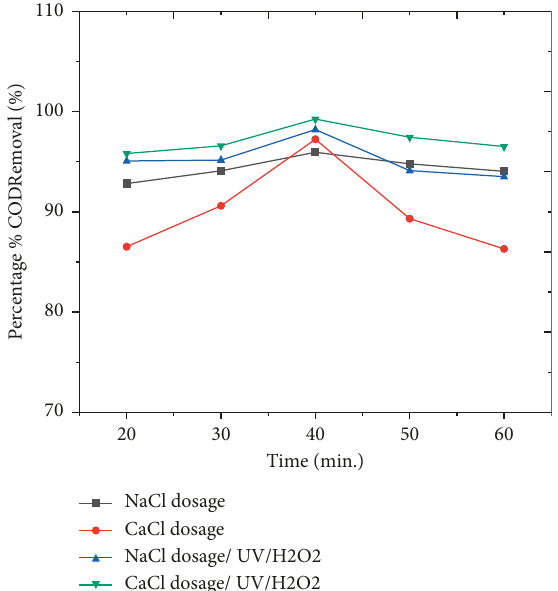
Figure 3: Effect of time on COD removal efficiency from coffee processing wastewater.